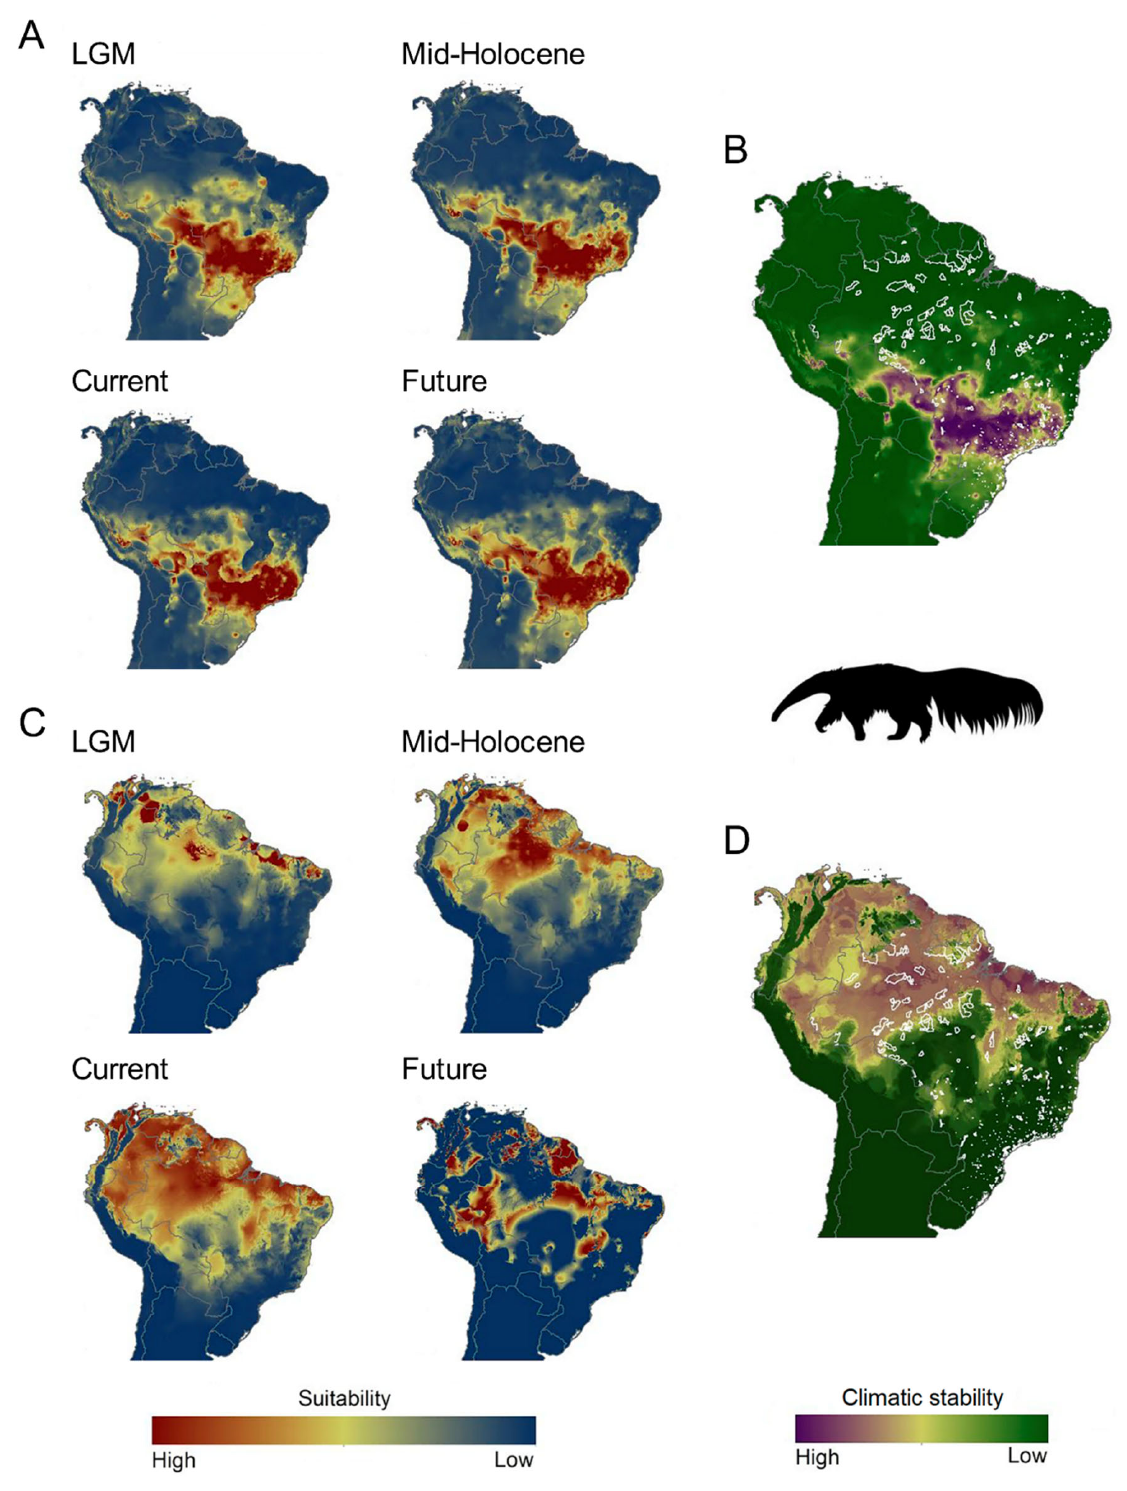
Figure 6. Distribution models of ( A ) CEPTAF and ( C ) AM clusters of the giant anteater for Last Glacial Maximum (LGM), Mid-Holocene, current (~1960–1990), and future (2070) climate conditions. Higher values indicate pixels with higher potential for population occurrence. Climatic stability maps are based on distribution models for ( B ) CEPTAF and ( D ) AM clusters. Protected areas are delimited by white lines [91].